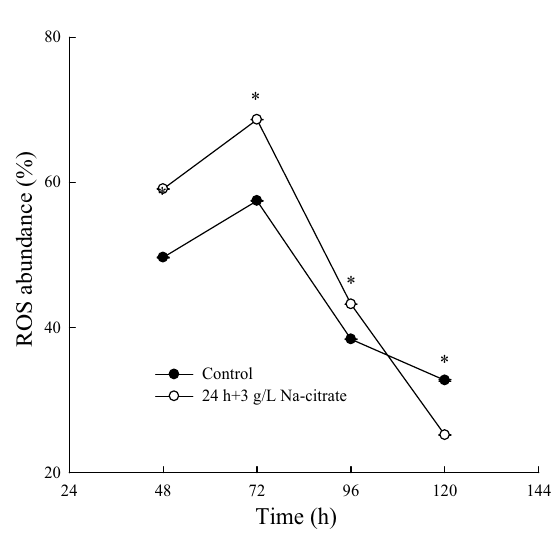
Fig. 5 Intracellular reactive oxygen species (ROS) generation. The figure represents variation in ROS abundance with time, where * represents p < 0.05 compared to the control. The solid and hollow circles represent the intracellular ROS abundance in the control group and the Na-citrate group, respectively